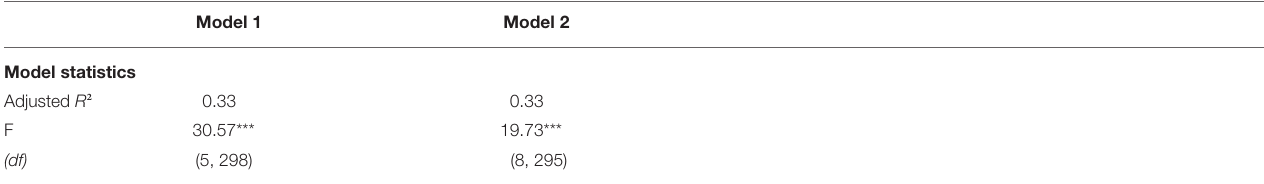
TABLE 3 | Multiple regression analyses for predicting state